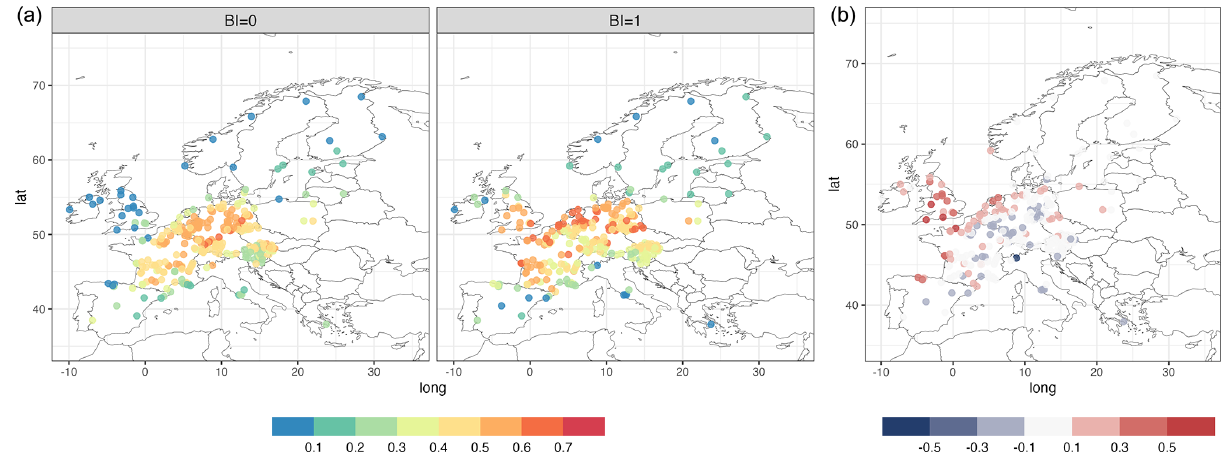
Figure 4. (a) Spatial distribution of the upper tail dependence parameter derived from the copulas when BI = 0 and BI = 1. (b) Differences between the values of the upper tail dependence parameter when BI = 1 minus the values when BI = 0.